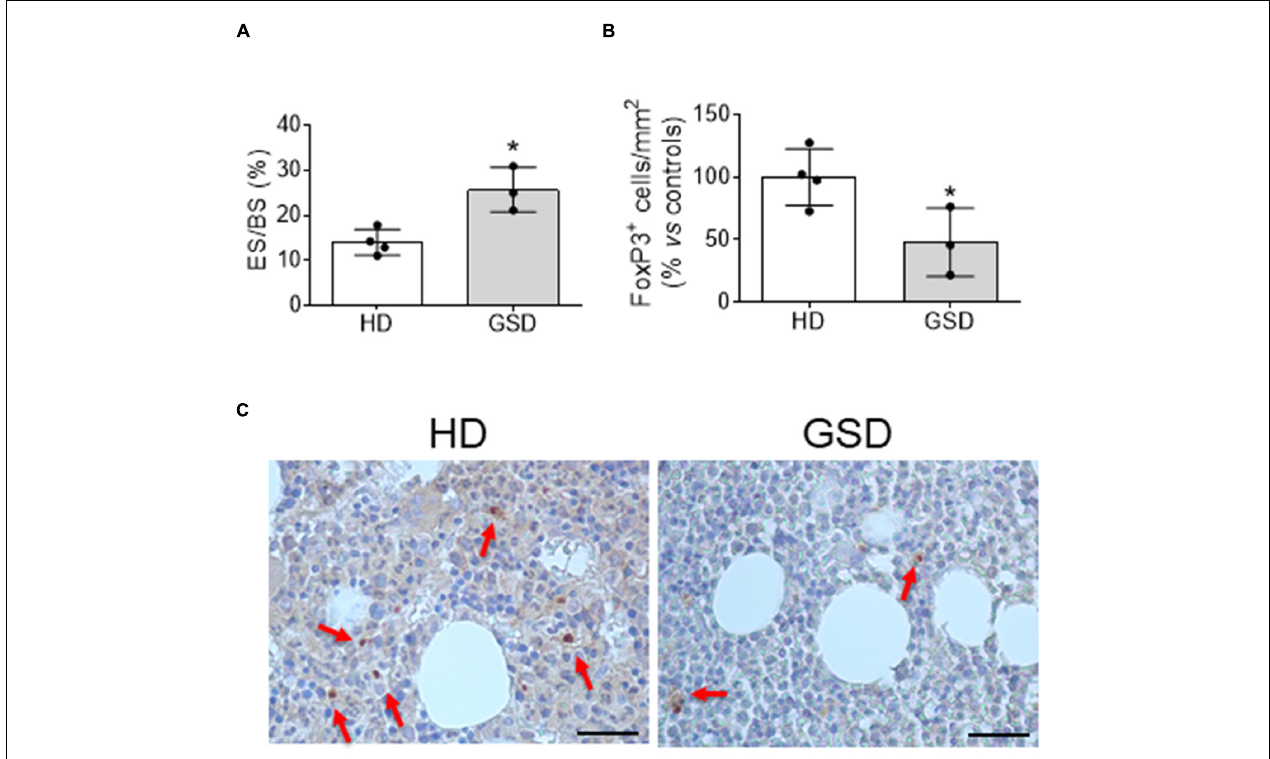
FIGURE 2 | Bone biopsy analysis of four HD and three patients. (A) Histomorphometric analysis of Eroded surface/Bone surface (%). (B) Histomorphometric analysis of FoxP3 + cells/Total Bone marrow Area. (C) Representative pictures of immunohistochemical analysis of FoxP3. The arrows indicate FoxP3 + cells. Scale bar: 25 µ m. Results presented as percentage vs. aged-matched HD. Results are expressed as mean ± SD. * p <